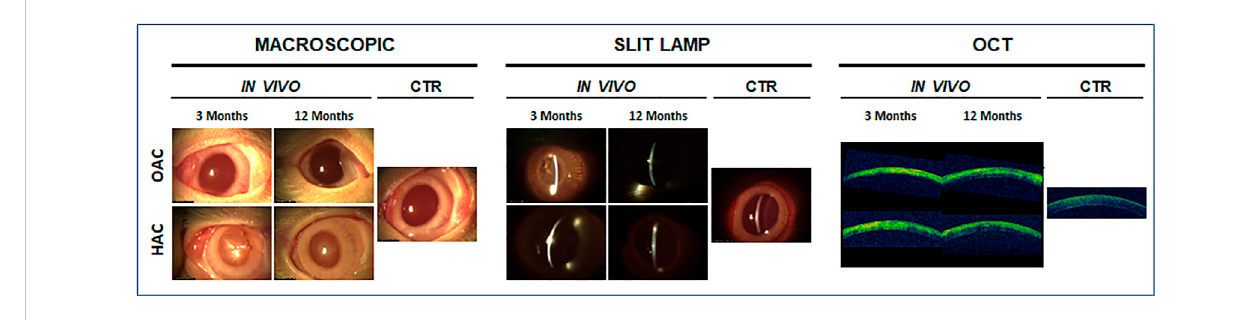
FIGURE 1 Ophthalmologic analysis of rabbit eyes grafted with the orthotypical (OAC) and heterotypical (HAC) arti fi cial corneas and control eyes (CTR). Macroscopic photographs, slit lamp observations and optical coherence tomography images (OCT) are shown for each type of sample after 3 and 12 months of in vivo